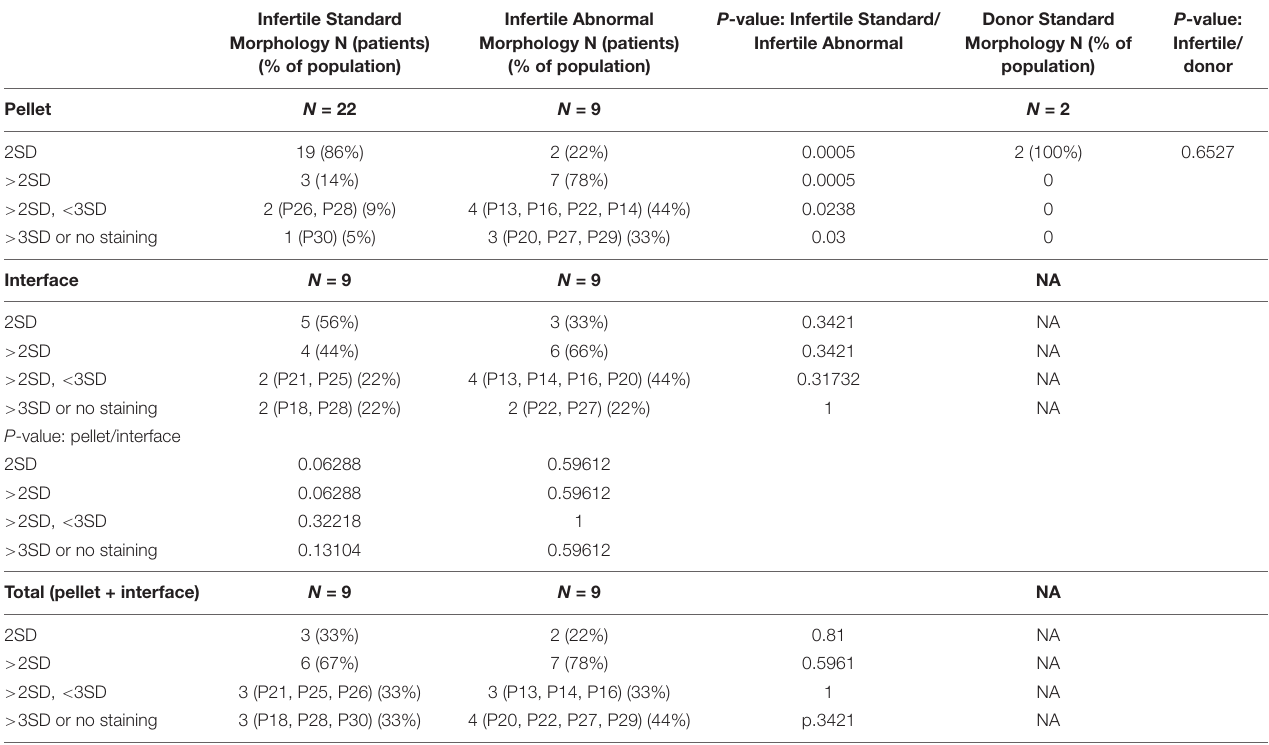
TABLE 2 | Summary table comparing the various populations of men examined in the study. Infertile Standard Infertile Abnormal Morphology N (patients) Morphology N (% of population)